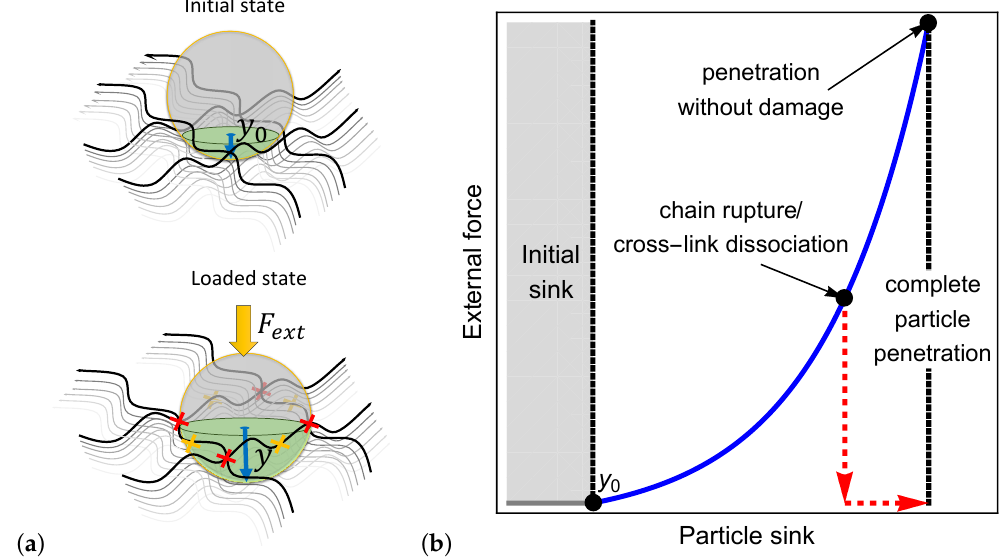
Figure 1. ( a ) Illustration of the initial particle sink and the sink under an external force. The yellow and the red x marks denote chain rupture and cross-link dissociation, respectively. ( b ) A schematic of the external force required for complete penetration of a particle into a polymer